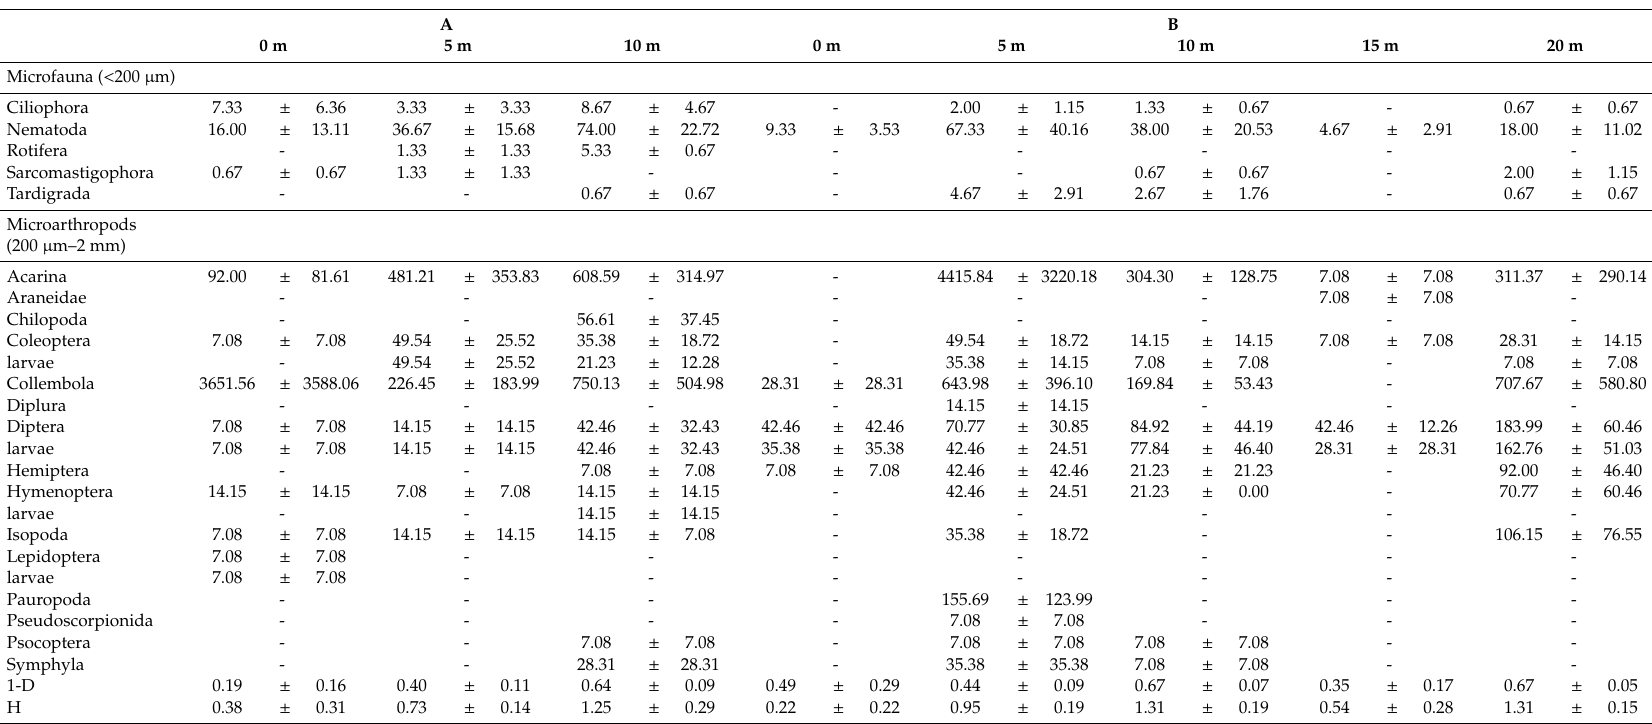
Table 2. Average ± Standard Error of the number of individuals for each faunal group (microfauna per 10 g and Arthropoda per m 2 ) found along transects in study sites, together with the Simpson Index of Diversity (1-D) and the Shannon Diversity Index (H) calculated for Arthropoda. A B 0 m 5